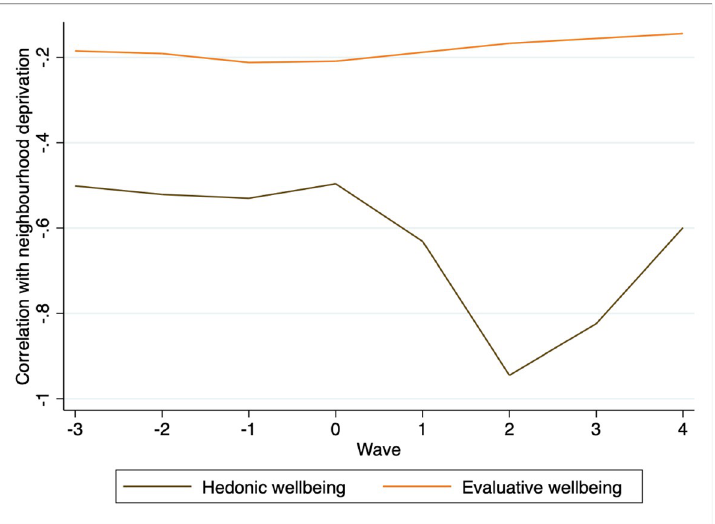
Fig 1. Neighbourhood correlation with hedonic and evaluative wellbeing, base model, OLS cross-section by wave. Note: Weighted results, all coefficients statistically significant at p < 0.01. For evaluative wellbeing, results are estimated only in wave 2 and 4. Authors computation on Understanding